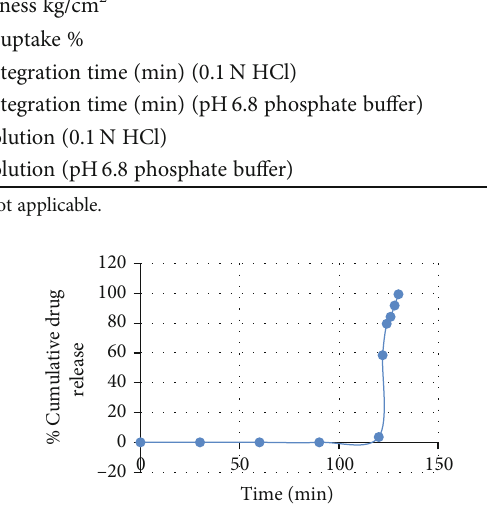
Figure 4: In vitro dissolution pro fi le of formulation F8.